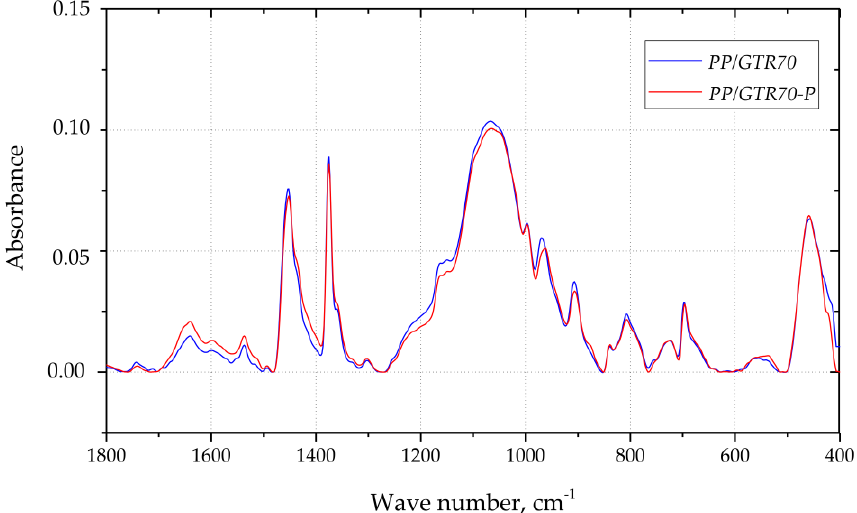
Figure 11. FT-IR spectra of interphase area recorded for PP/GTR70 ( blue ) and PP/GTR70-P ( red ).